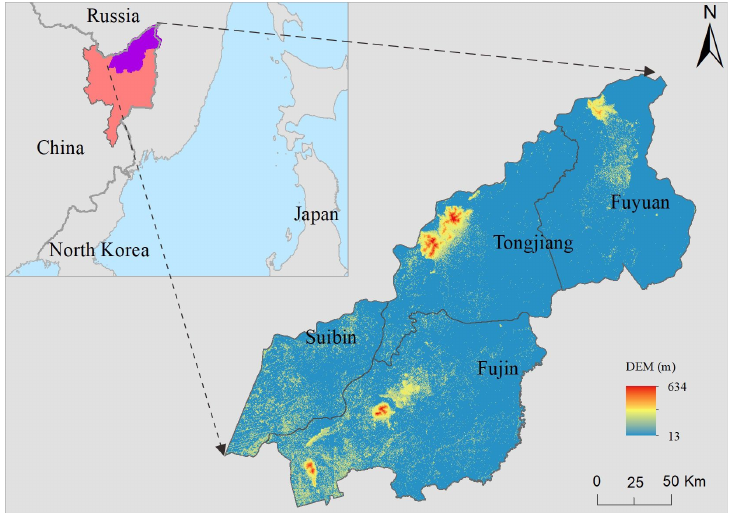
Figure 1. Location map of the study area. Note: In the location diagram in the upper left corner, the red area is Sanjiang Plain, and the purple area is our study area. We collected land use data, surface temperature data and auxiliary data. For land use data, because the collected land use data only had three periods of 2000, 2005 and 2010,